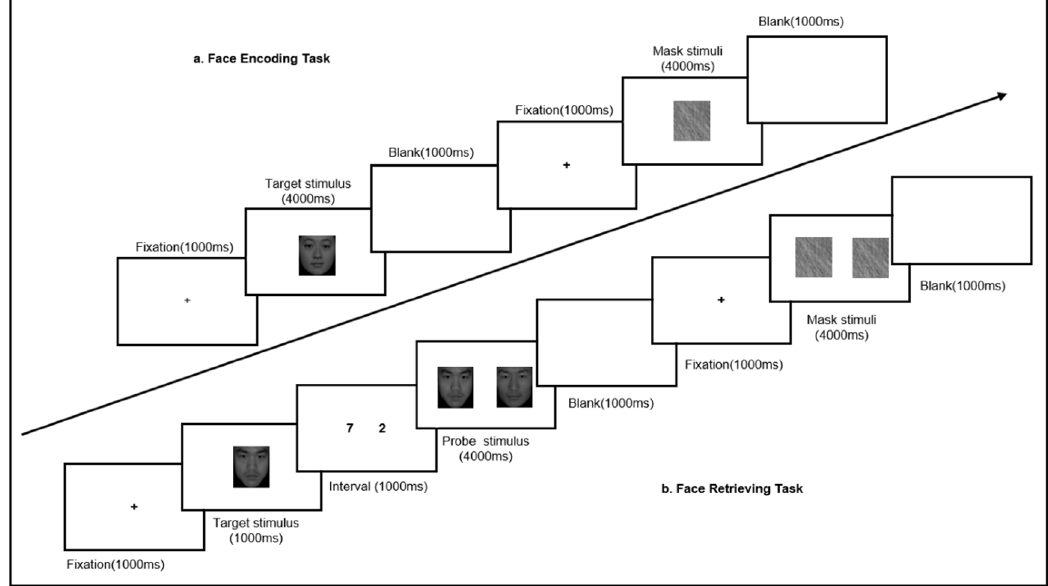
Figure 1. A demonstration of face encoding and retrieving paradigm. ( a ) Face encoding Task. ( b )Face Retrieving Task.